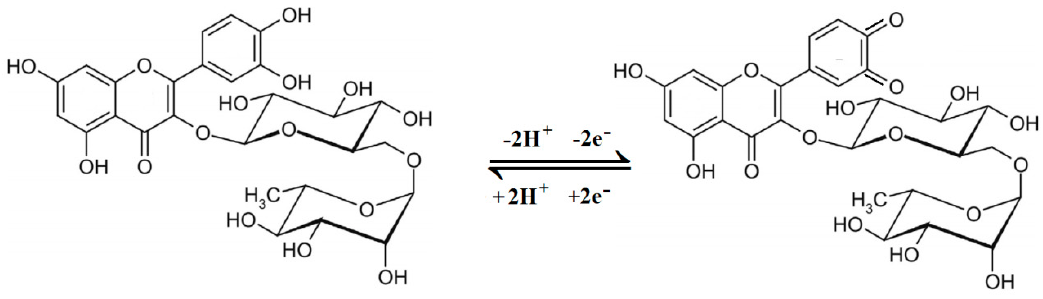
Scheme 1. Electrochemical reaction mechanism of